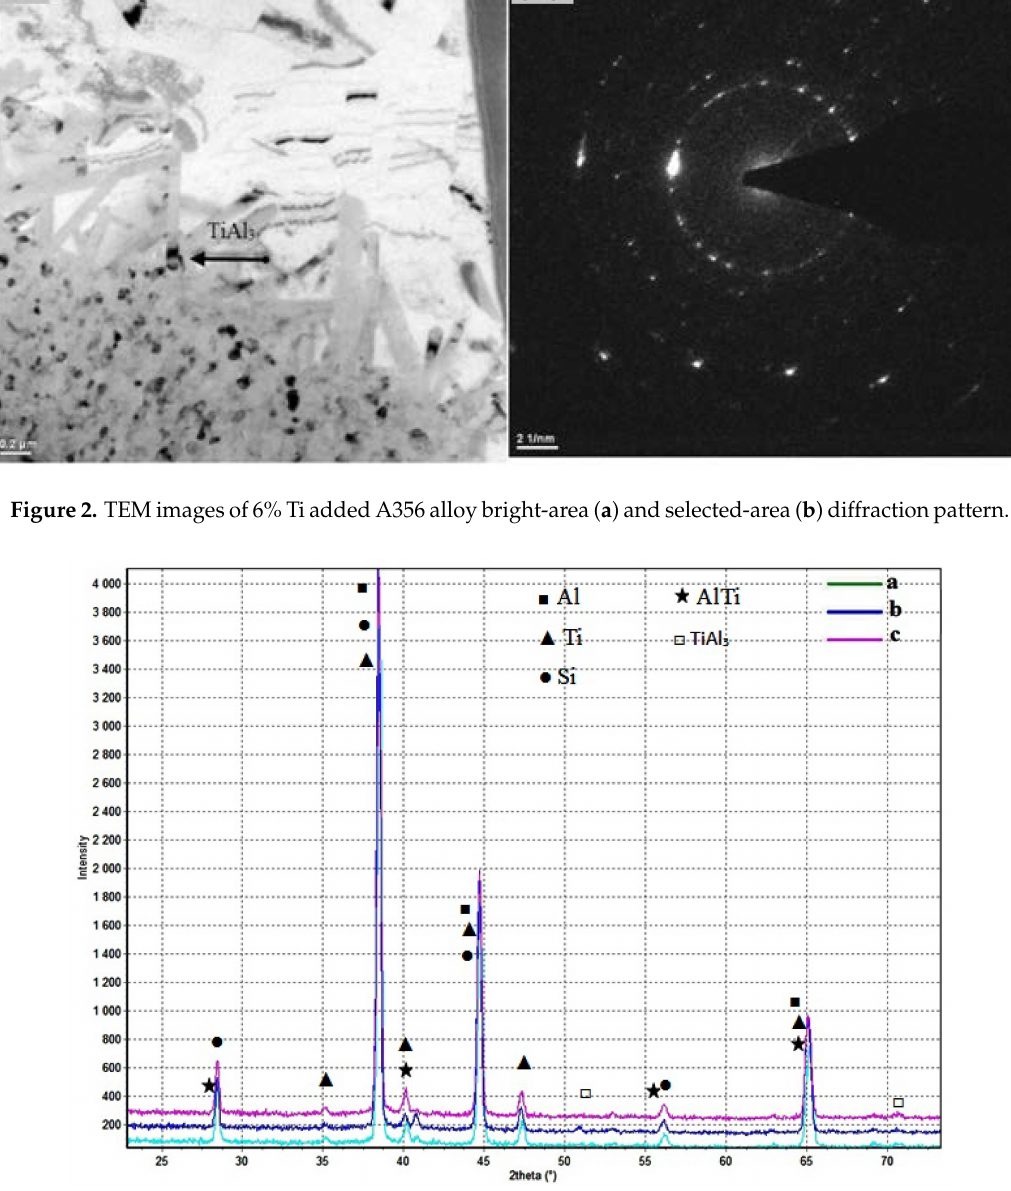
Figure 3. XRD results of A356-Ti alloy with 4% ( a ); 6% ( b ); and 8% ( c )